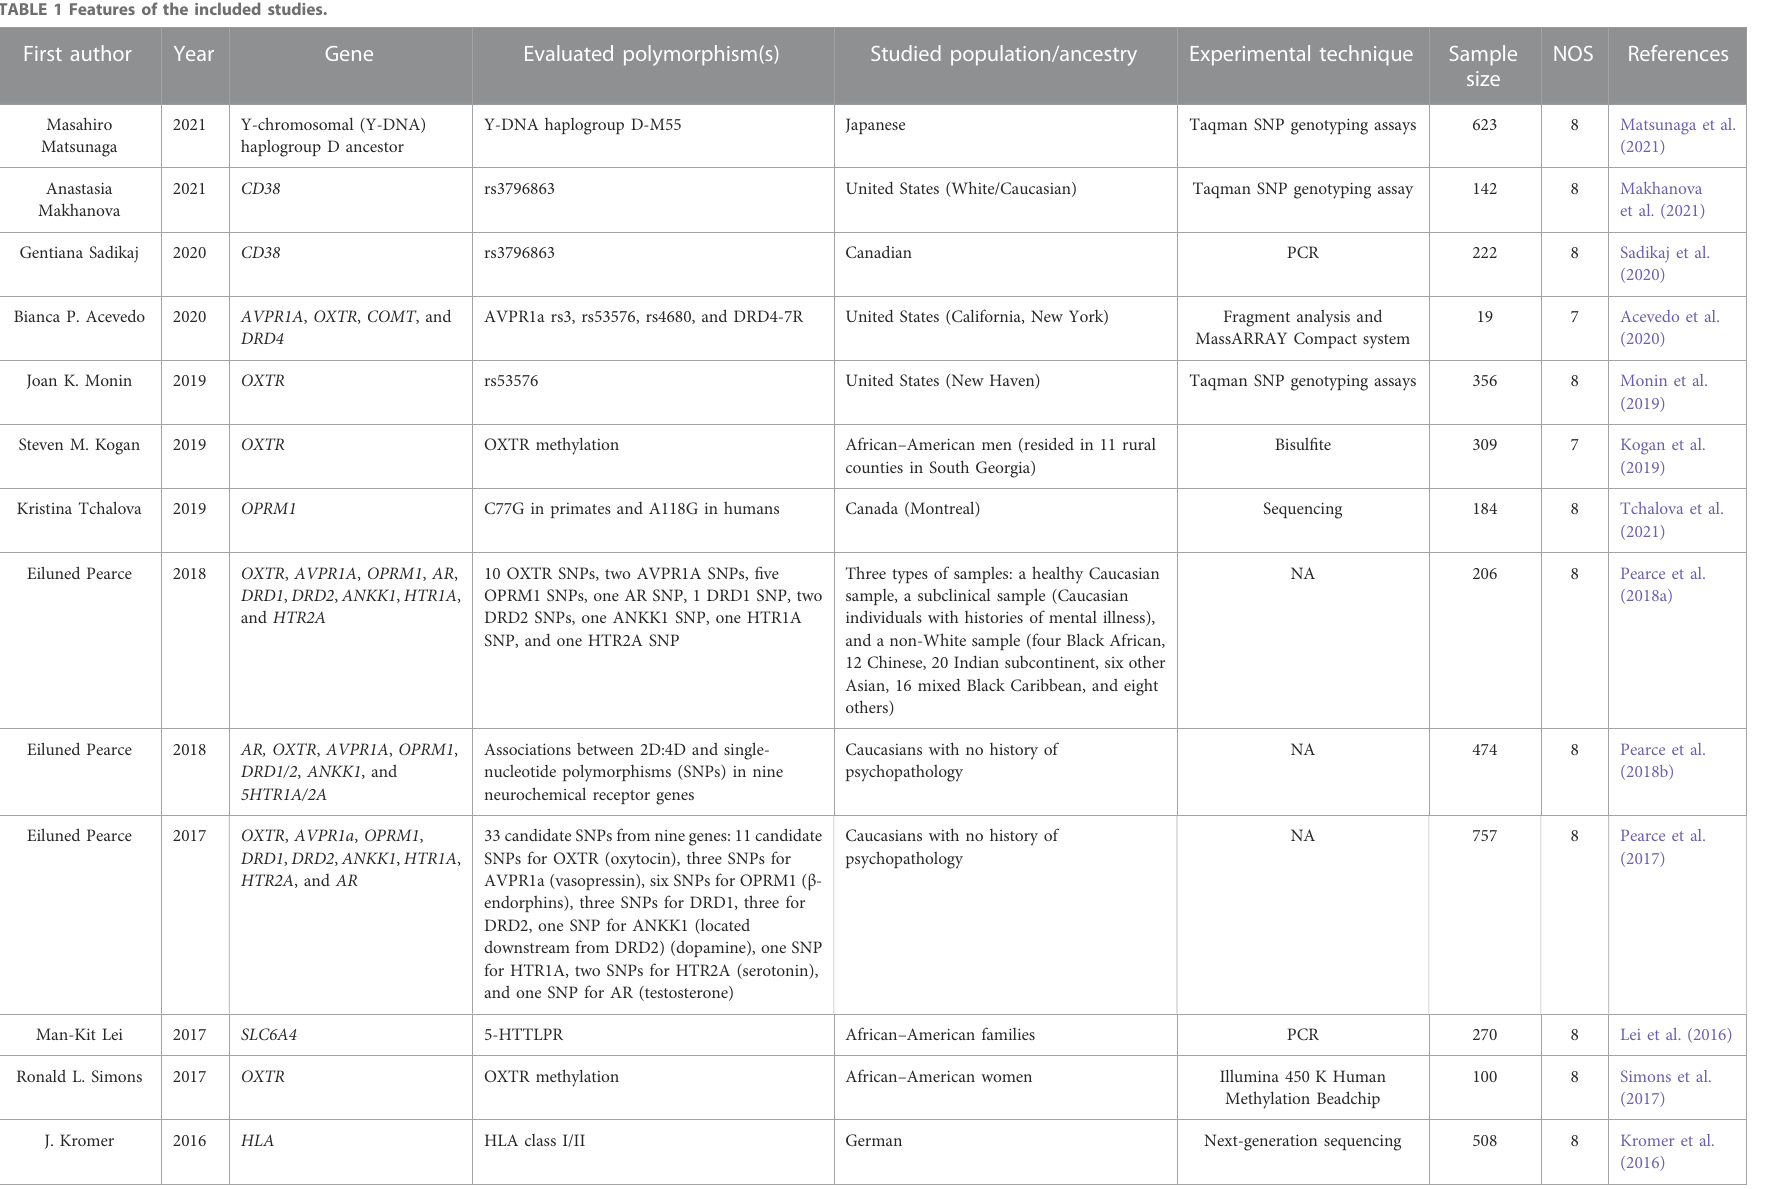
TABLE 1 Features of the included studies.